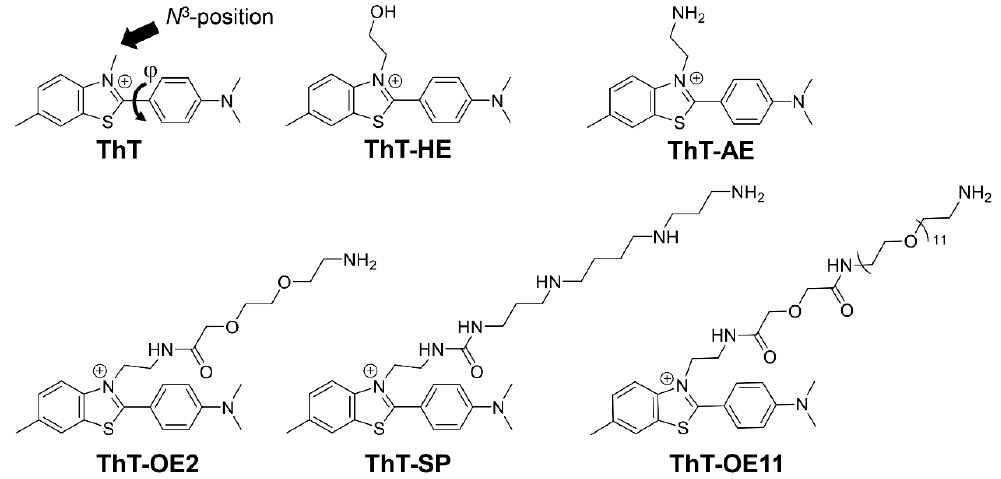
Figure 2. Chemical structures of ThT, ThT-HE, ThT-AE, ThT-OE2, ThT-SP, and ThT-OE11.